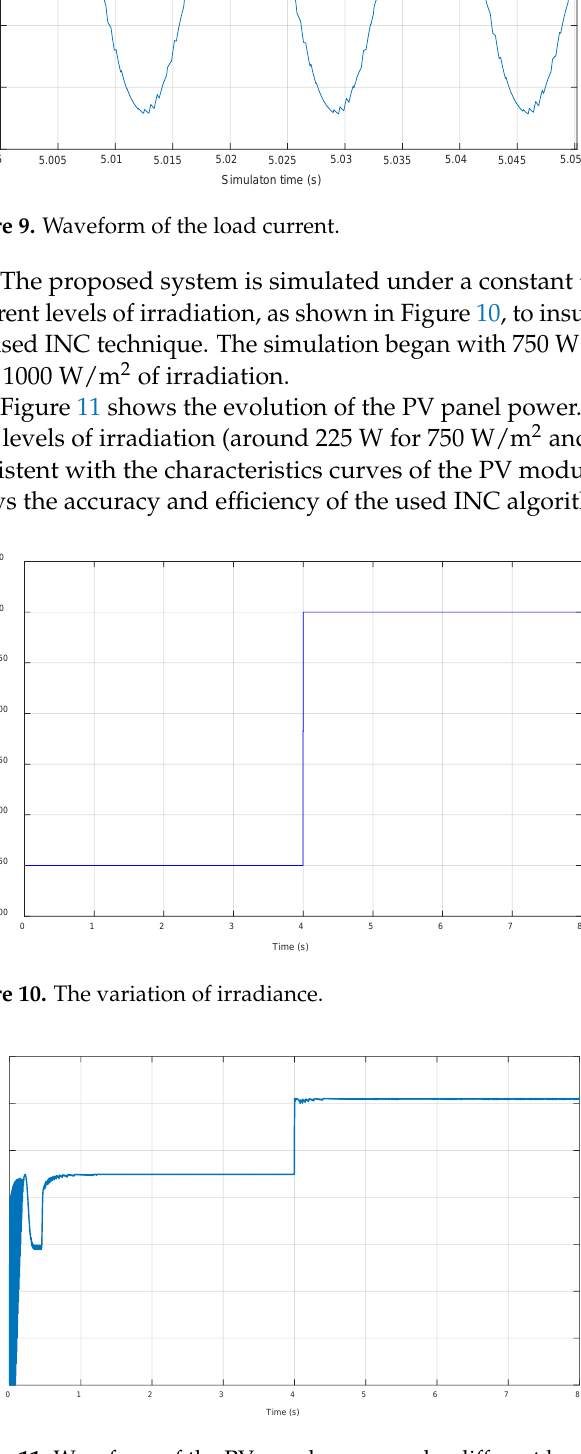
Figure 11. Waveform of the PV panel power under different levels of irradiation.